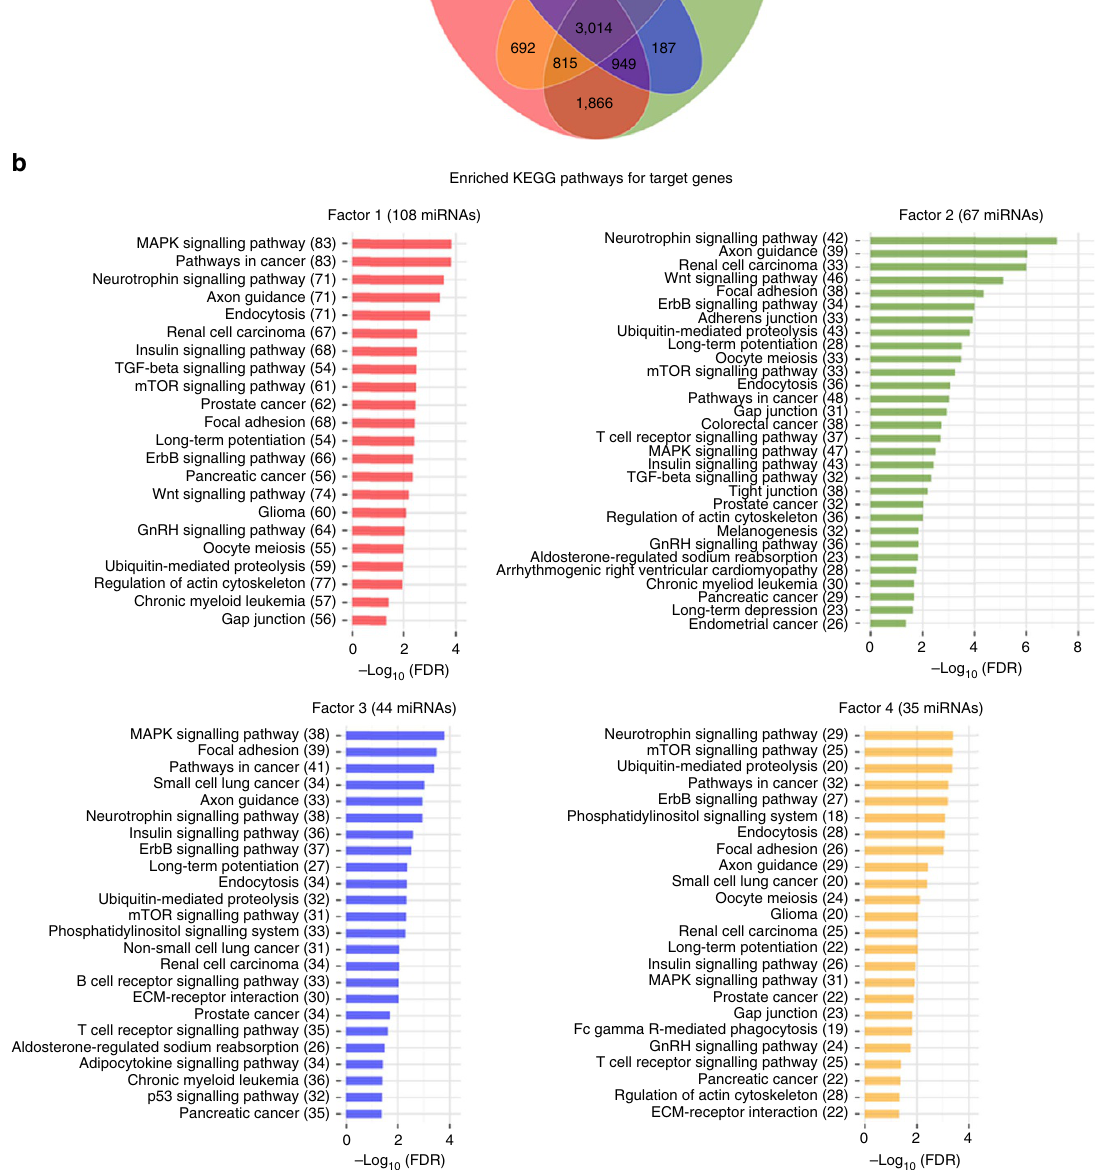
Figure 6 | MicroRNA target prediction and pathway enrichment analysis. ( a ) Venn diagram showing the overlaps of the predicted sets of unique mRNAs targeted by miRNAs for each factor. ( b ) Significantly (Benjamini Hochberg corrected P value o 0.05) enriched KEGG pathways for target genes for factors 1–4. The number of miRNA involved in targeting at least one gene in a given pathway are shown in